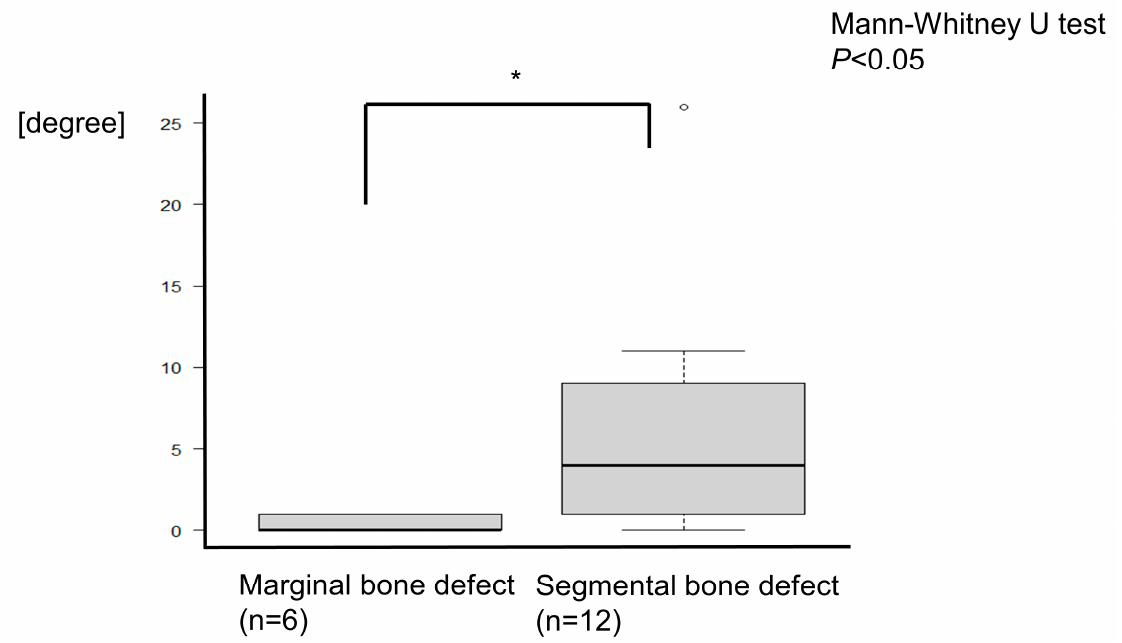
Figure 15. The deviation of the condyle was evaluated at the point of the condylar axial angle. For the marginal bone augmentation, the angle differences between pre- and postoperation were mean 0.33 ± 0.52°, whereas, for the segmental defects, the mean angle was 6.41 ± 7.46°. The condyle was more deviated in segmental defects than in marginal bone resection. There were statistically significant differences (Mann–Whitney U test, * P < 0.05).